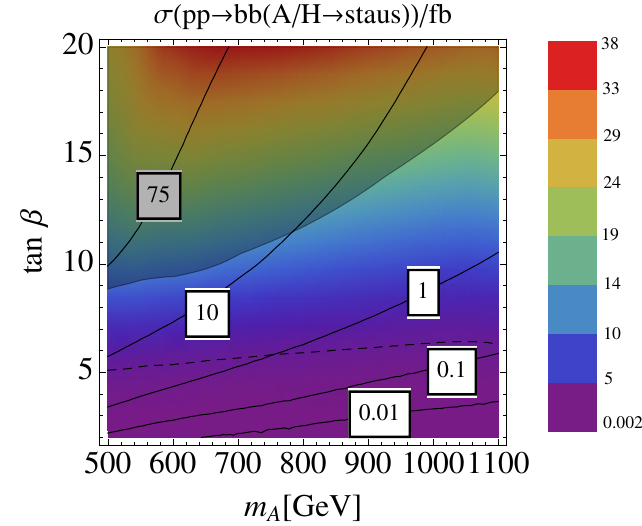
Figure 10 . Solid contour lines with numerical labels denote the production cross section of staus from b-associated production and decay of A; H (combined) in fb. For this plot we (cid:12)x m A = 2 m ~ (cid:28) + 50 GeV, (cid:22) = max(500 ; m ~ (cid:28) + 25) GeV, and set A (cid:28) to the maximum value allowed by the 2 absolute vacuum stability bound at each point. The color coding denotes the ratio of production cross section of staus from this decay process to the direct production cross section of maximally mixed staus, (cid:27) ( pp ! b (cid:22) b ( A; H ! staus)) =(cid:27) ( pp ! staus). The dashed curve denotes the contour along which these two production cross sections are equal. The shaded region is ruled out from the current A=H ! (cid:28)(cid:28) LHC searches [1,